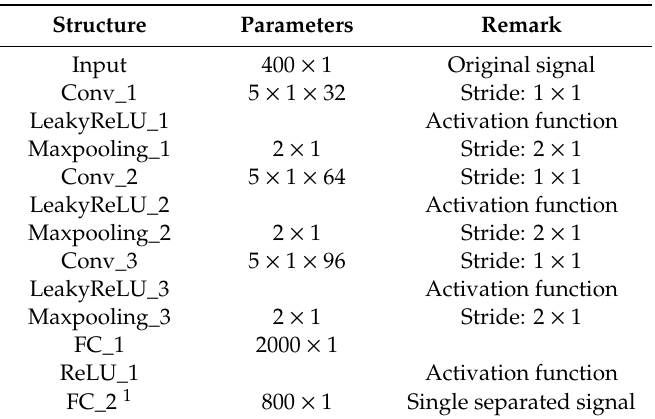
Table 1. Specific structure of